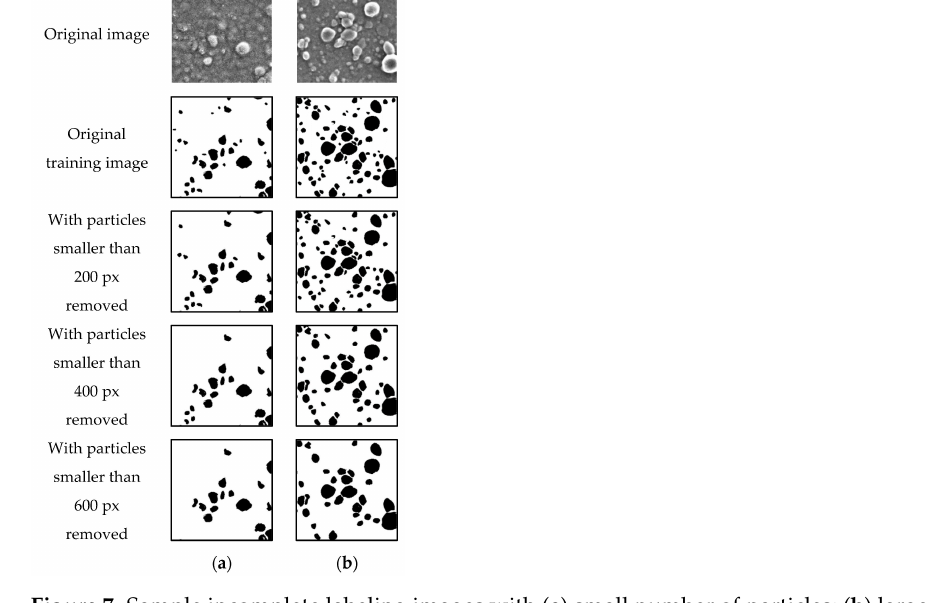
Figure 7. Sample incomplete labeling images with ( a ) small number of particles; ( b ) large number of